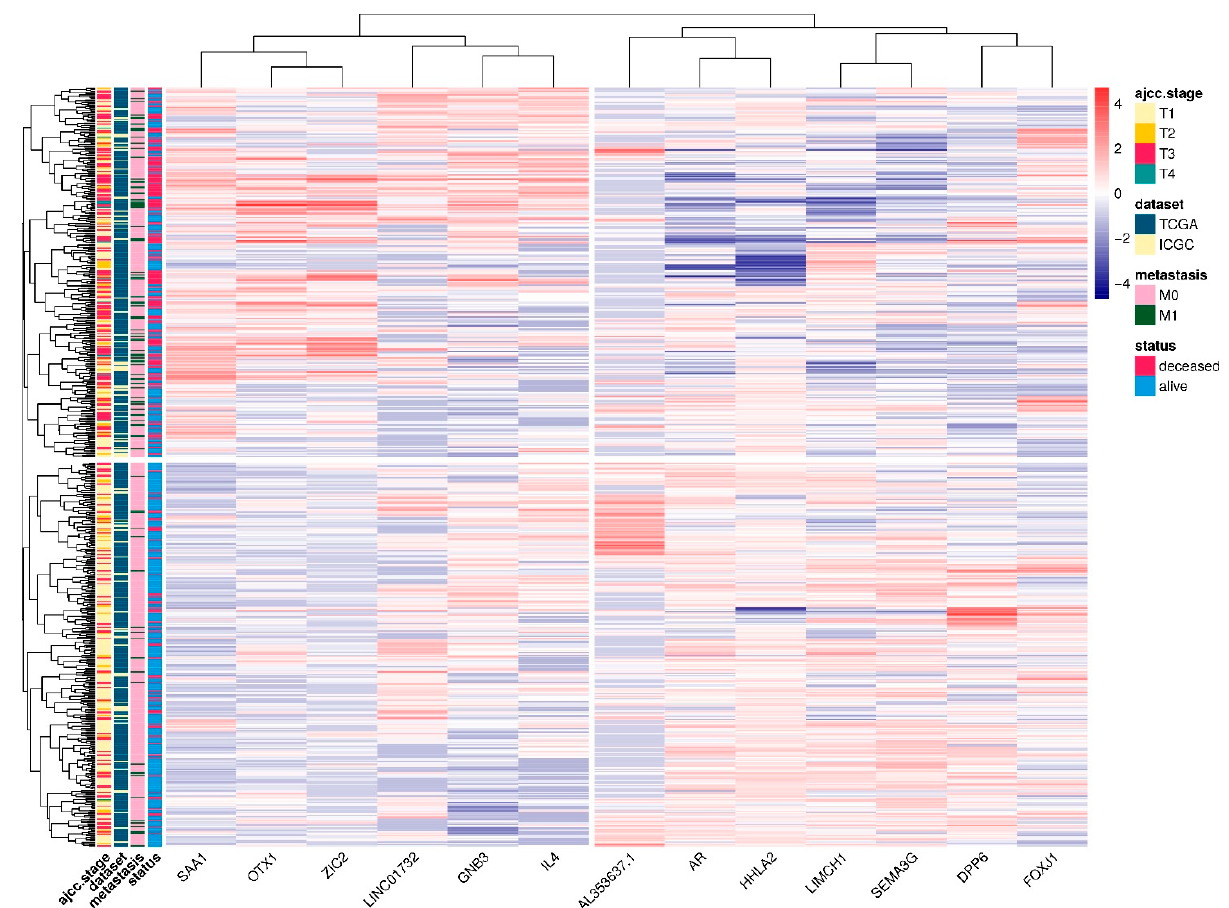
Figure A10. Heatmap with hierarchical clustering combining RNA-seq expression of patients on TCGA-KIRC and ICGC-RECA. Columns are genes of the mRMR signature. Rows indicate RNA-seq expression of 590 patients of TCGA-KIRC and ICGC-RECA. Data of patients with distant metastasis that cannot be assessed (MX) were removed in order to clarify the clustering.